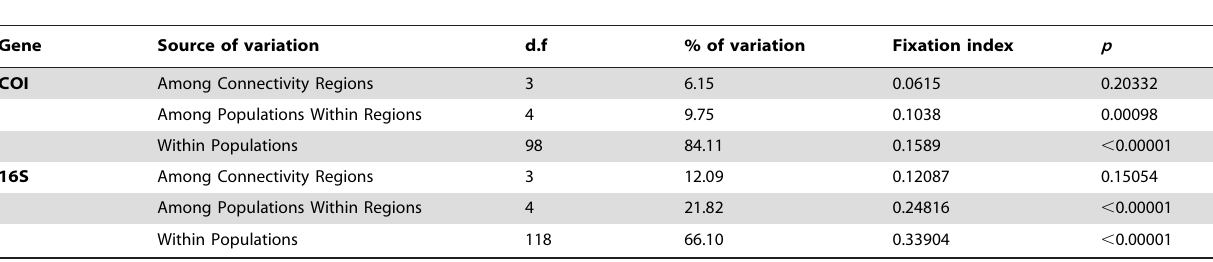
Table 2. AMOVA results for C. pica COI and 16S for the four Caribbean connectivity regions [9].